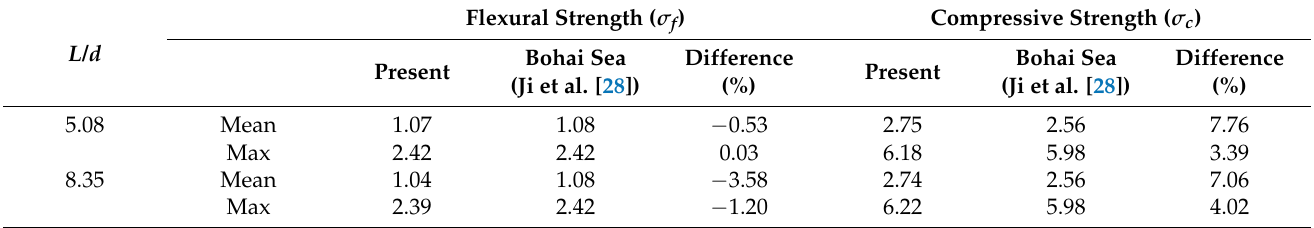
Table 3. Compressive strength and flexural strength in the Bohai